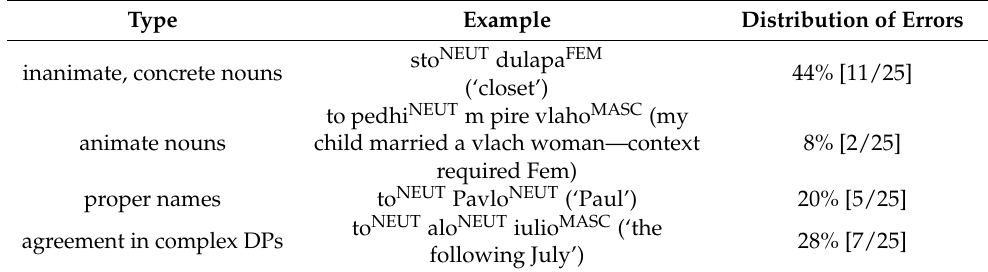
Table 8. Frequency of gender marking errors in MG DPs by L1VA–L2MG